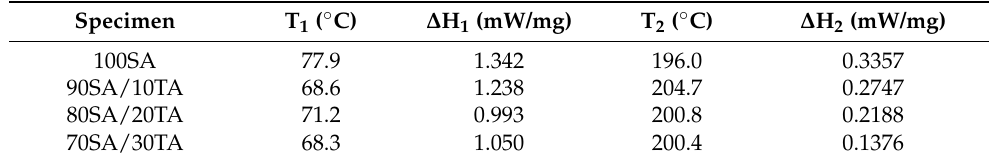
Table 2. The maximum temperature of the process (T) and the enthalpy of the processes ( ∆ H) measured during the samples heating by differential scanning